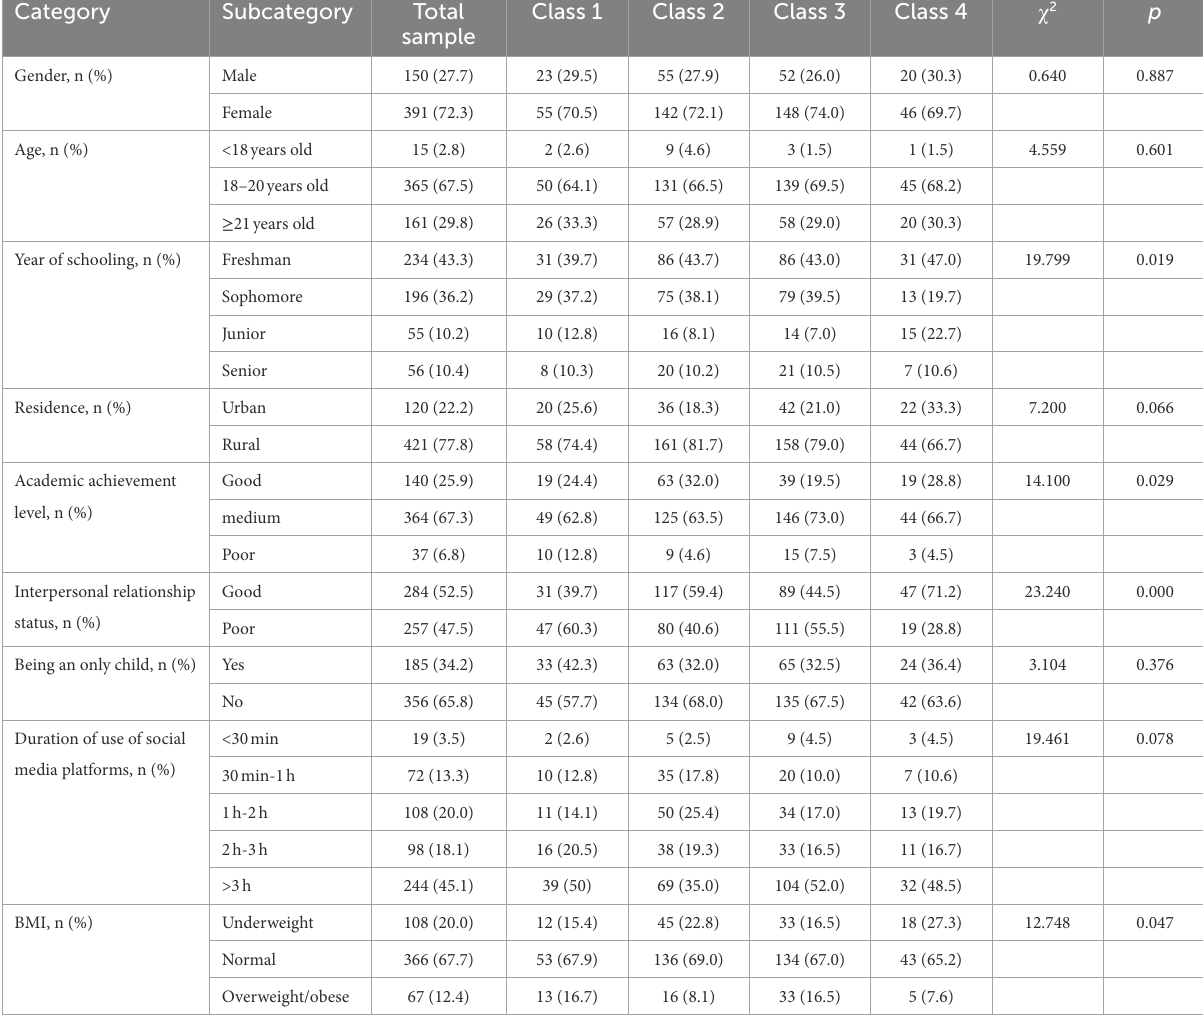
According to the results of one-sample Kolmogorov–Smirnov tests, the scores of SCSS and BAS-2 should be expressed by the “mean (standard deviation)” with normality distribution ( p > 0.05), while the scores of the three subscales of DASS-21 were expressed as “median (interquartile range [IQR])” due to the skewed distribution ( p < 0.01). So the average scores of body appreciation, self-concept clarity, depression, anxiety, and stress among nursing students were 34.61 (7.65), 39.56 (6.91), 10 (14), 12 (12), and 14 (12) respectively.